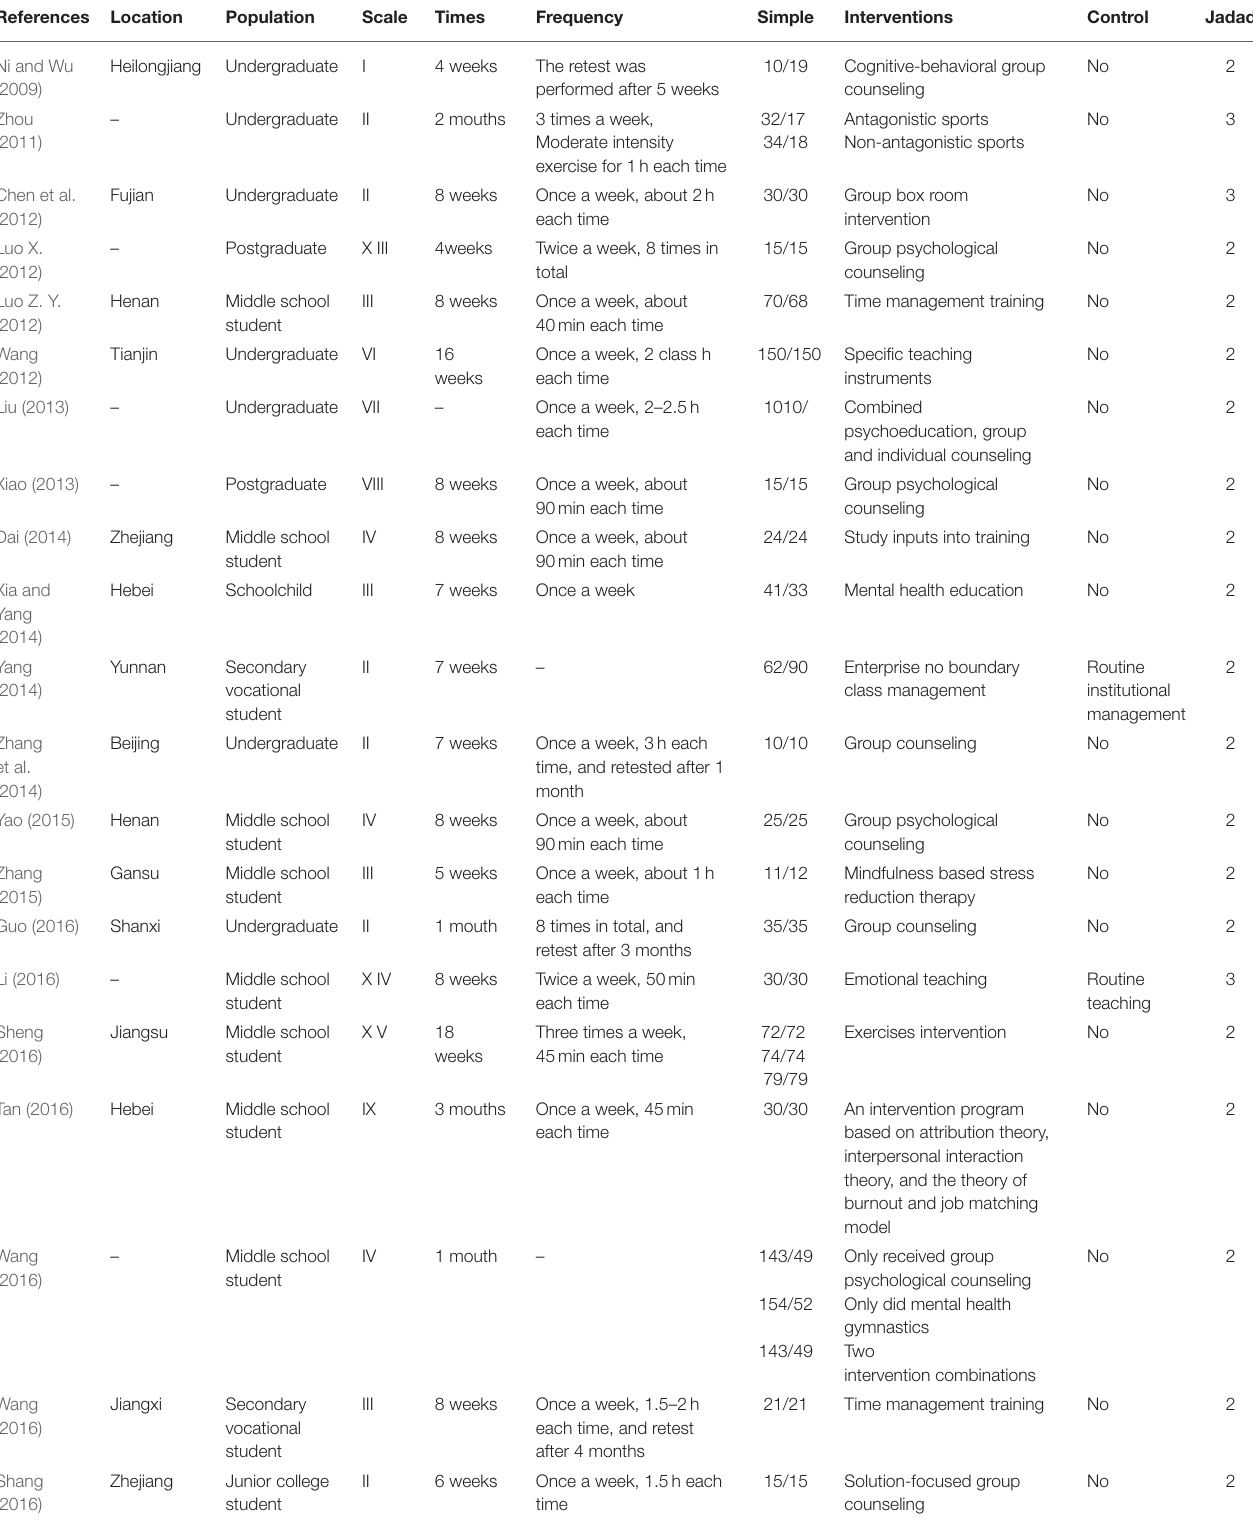
TABLE 1 | Characteristics of included